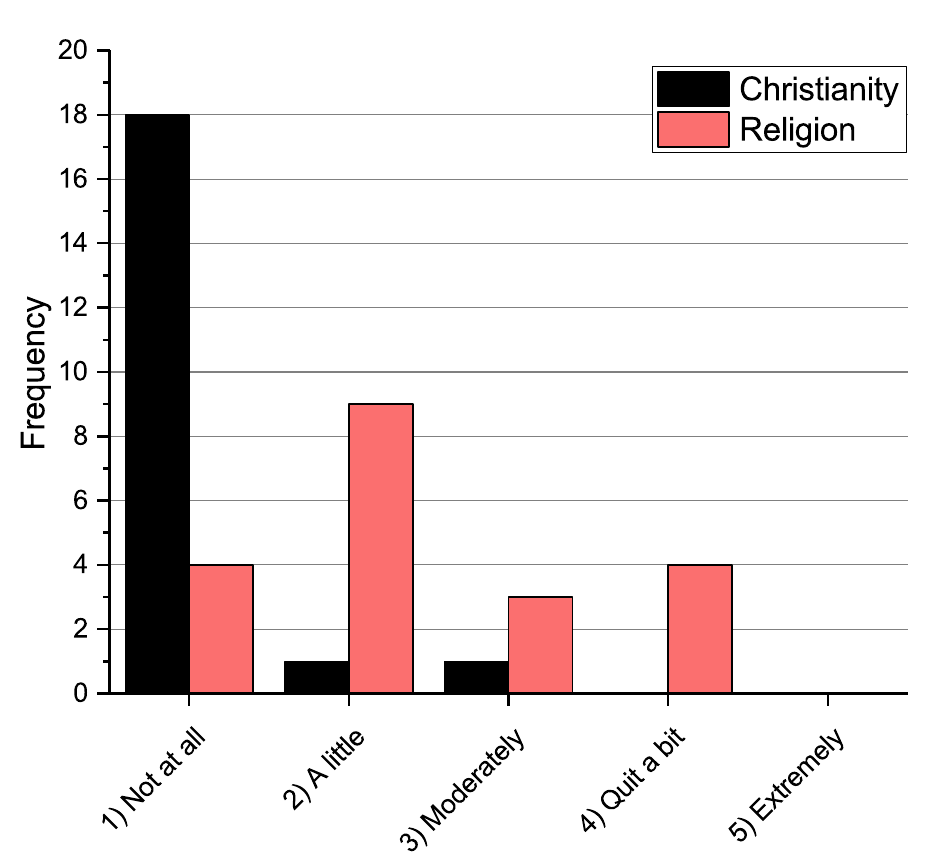
Figure 3: Evangelical distribution of “false” applied to Christianity and religion. N =